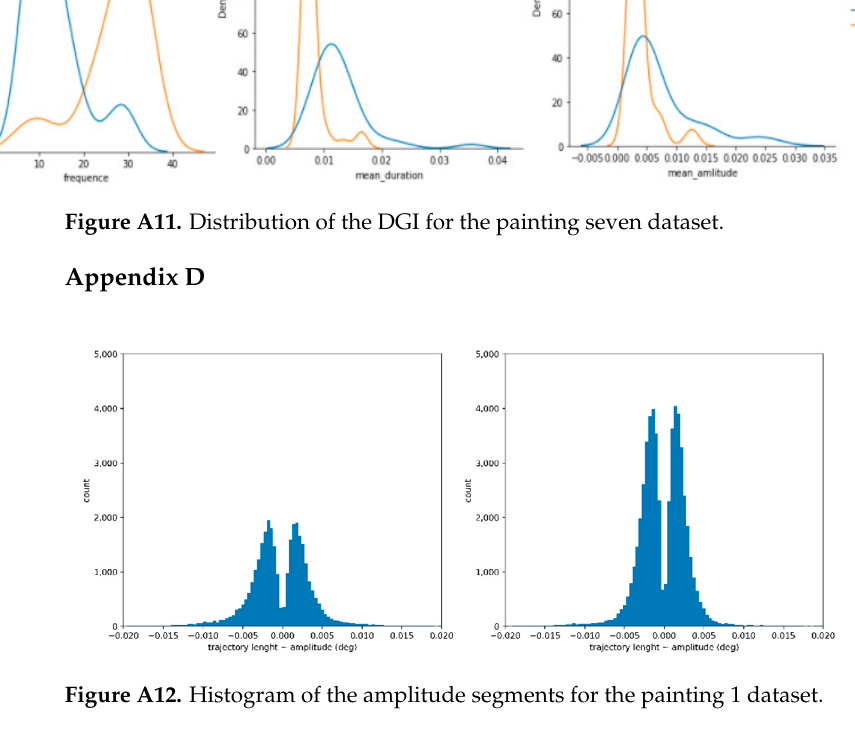
Figure A14. Histogram of the amplitude segments for the painting 3 dataset. Figure A15. Histogram of the amplitude segments for the painting 4 dataset.